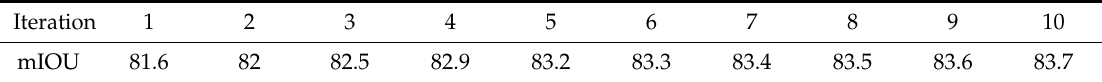
Table 7. E ff ect of the CRF iterations.